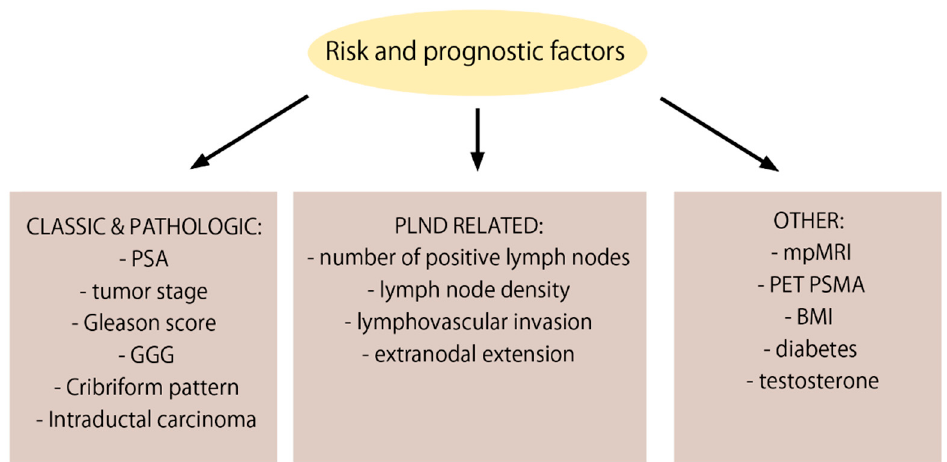
Figure 1. Risk and prognostic factors influencing outcomes in pN+ PCa patients after RP